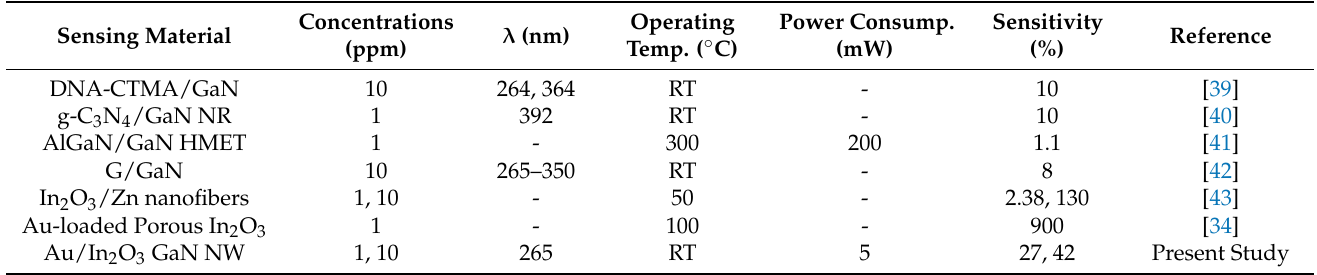
Table 2. Comparison of the NO 2 sensitivity of the sensors presented in this study with those reported in the